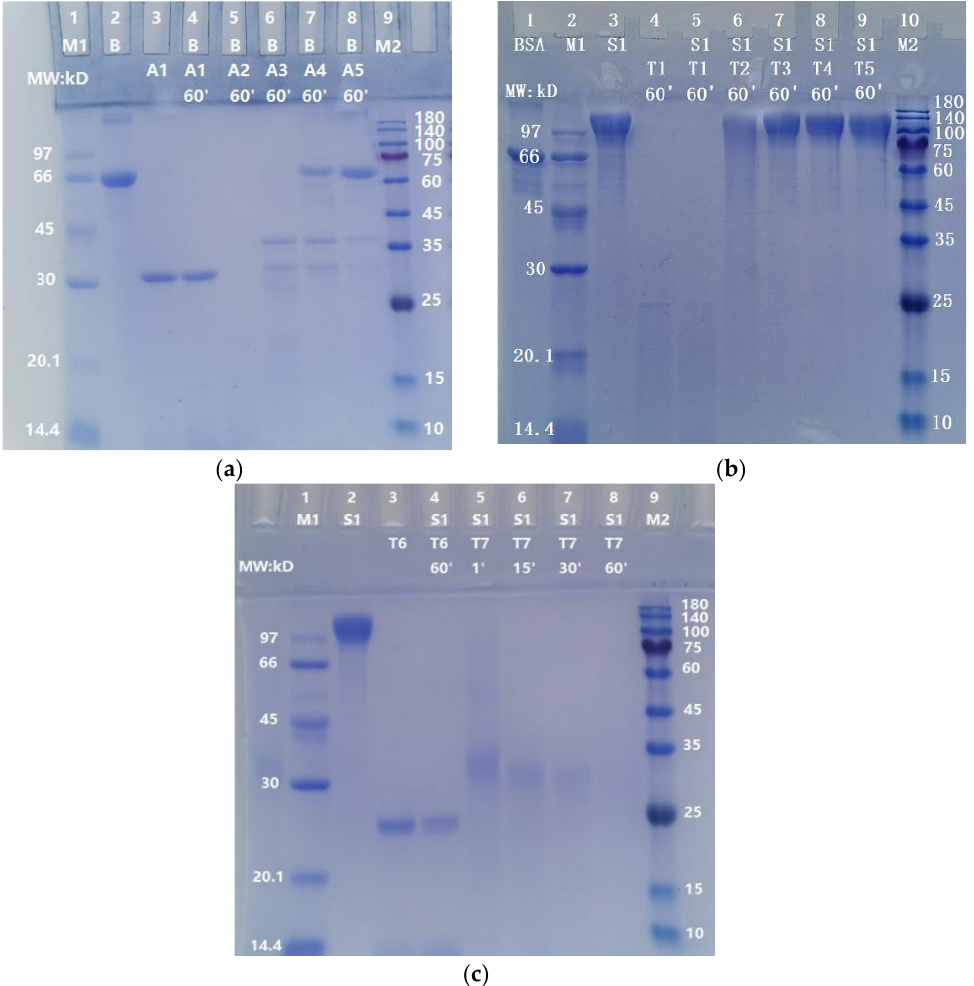
Figure 4. The action of ASPNJ on BSA and the action of trypsin on S1 protein. ( a ) BSA was degraded with ASPNJ with a total volume of 25 μL and degraded at 40 ℃ for 60 min. A: ASPNJ of different concentrations (A1 –A5 were 50, 1, 0.2, 0.04 and 0.008 μg/lane, respectively). B: BSA (10 μg/ lane). ( b ) Separate degradation reactions of different concentrations of trypsin to S1 protein, with a total vol- ume of 25 μL, were carried ou t at 40 °C for 60 min. ( c ) Individual degradation reactions of S1 protein by trypsin occurred at different incubation times from 1, 15, 30 to 60 min. S1 protein was 10 μg/lane. T: Trypsin at different concentrations (50, 1, 0.2, 0.04, 0.008, 100 and 5 μg/l ane for T1 – T7, respec- tively). The degradation effects were observed by running SDS-PAGE.